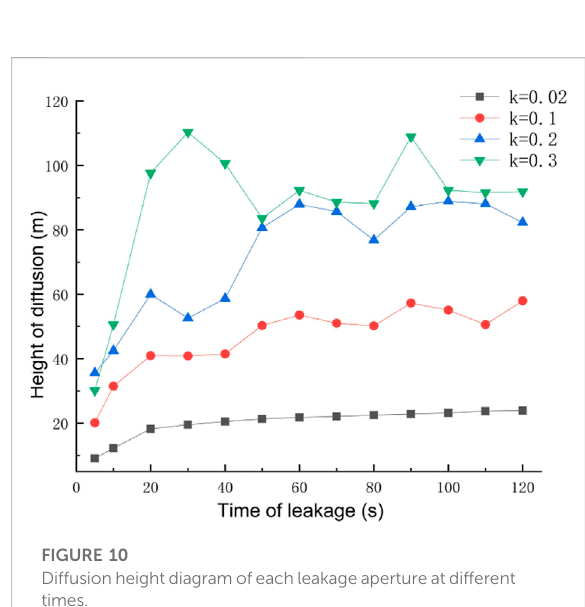
FIGURE 9 Concentration diagram of monitoring points under different leakage apertures after 120 s.